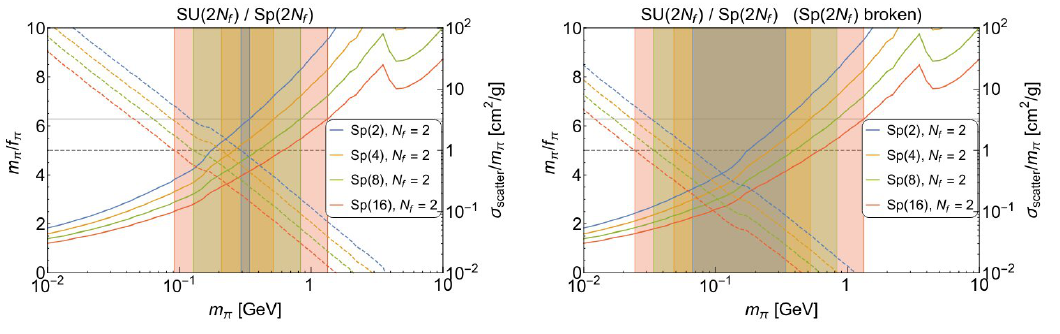
Figure 14: Allowed ranges of mesonic DM produced by the SIMP mechanism, for different confining Sp( N ) gauge groups, from Ref. [ 98 ] . Left: unbroken flavor sym- metry (degenerate quark masses); right: broken flavor symmetry (lifting degeneracy of π (cid:48)